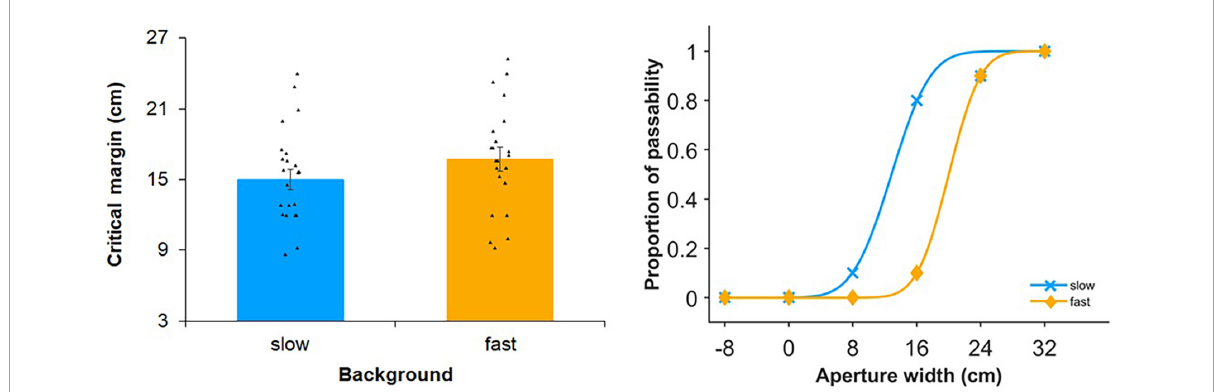
FIGURE2 Results of experiment 1. In the left panel, each bar graph represents an average of the critical margin across participants in each self-motion condition. The critical margin was 50% threshold when fitting the cumulative gaussian distribution functions using aperture width conditions in each self-motion condition. Dots indicate individual critical margins in each of self-motion conditions. In the right panel, passable rate of a representative participant in each aperture width condition was plotted and fitted with the cumulative gaussian distribution functions in each self-motion condition. Larger positive values indicate larger margin expansion. Error bars show standard